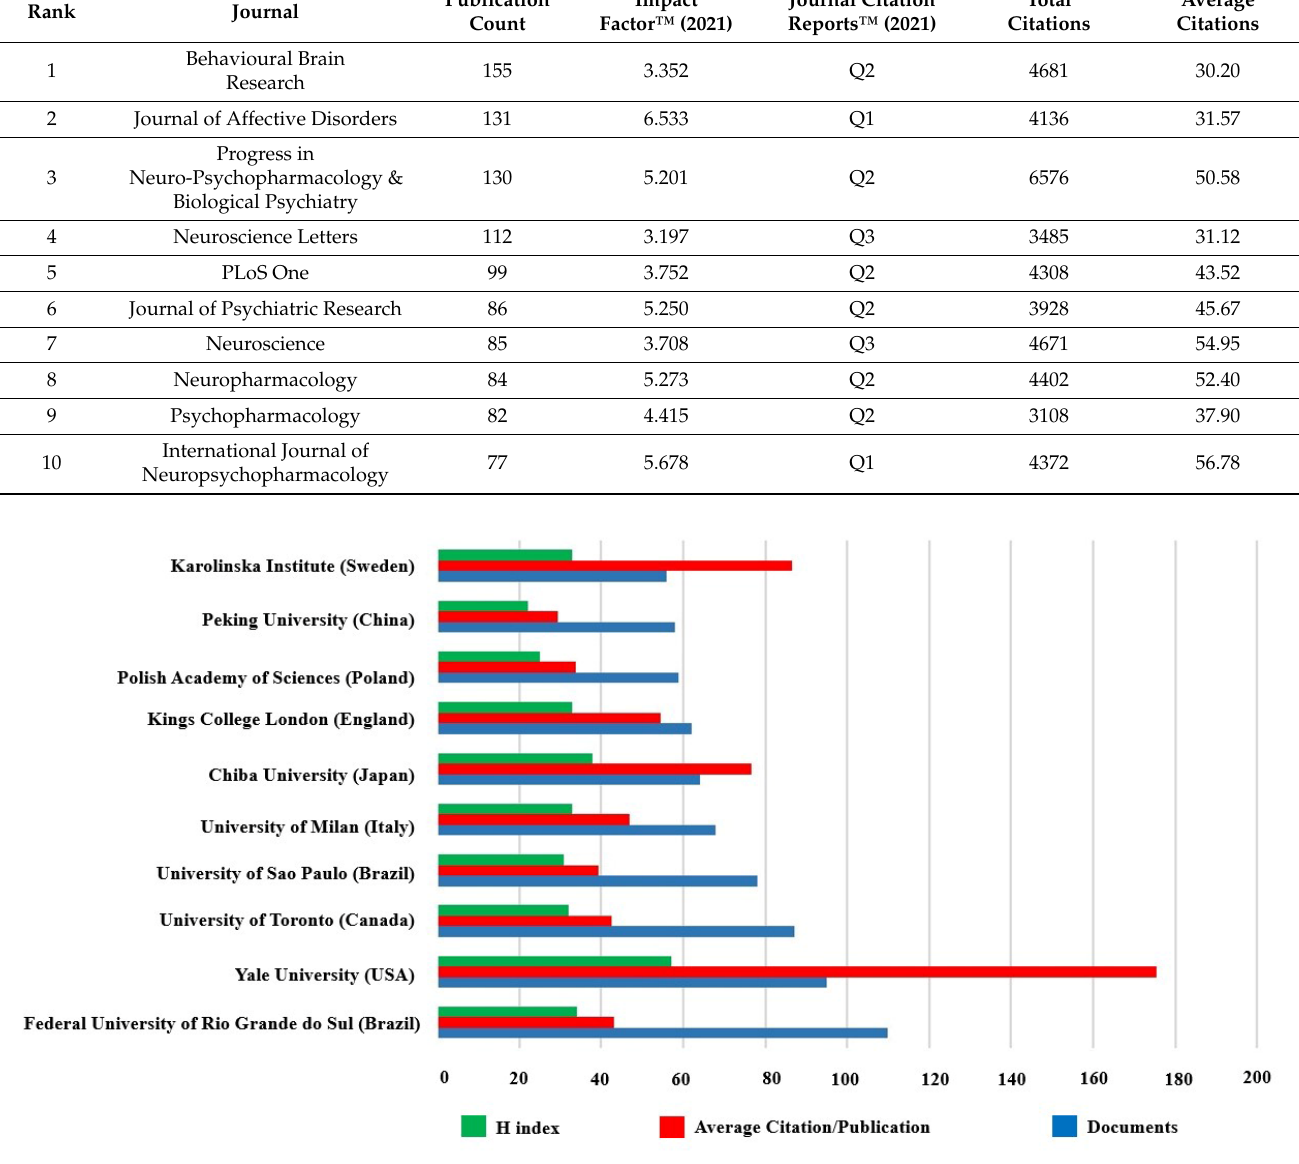
Figure 5. Contributions of institutions. The total number of publications, average citation per item, and H index of the top 10 institutions.